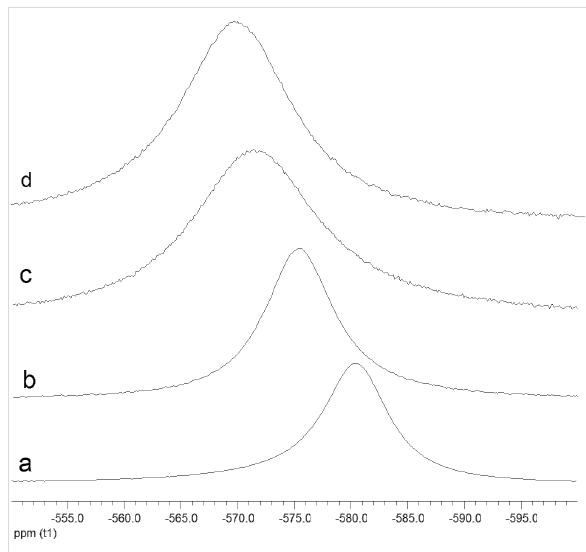
Figure 5: 51 V NMR spectra of complex 2 recorded at 50 °C. a) Spec- trum in CDCl 3 ; b) spectrum in CDCl 3 with 500 equiv of PhCHO